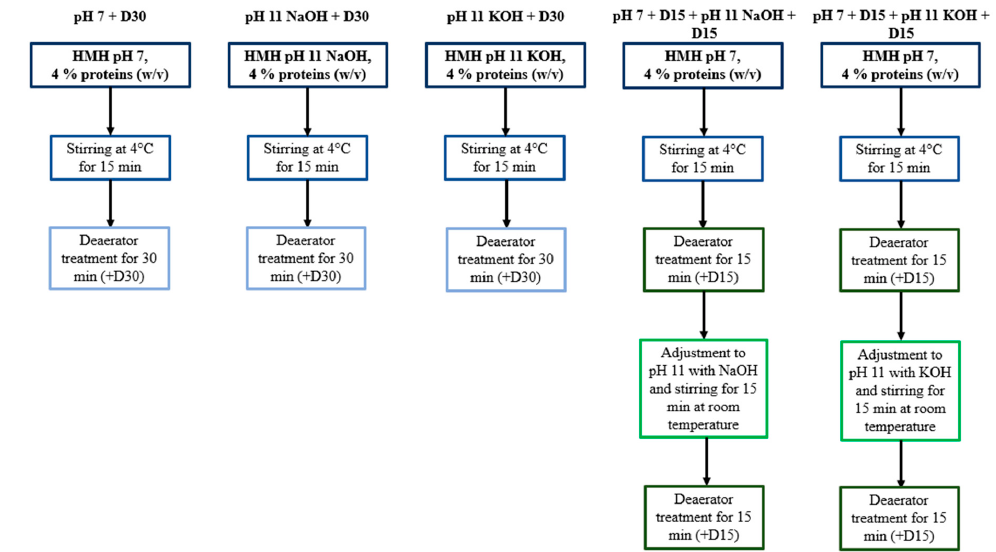
Figure 1. Summary of the experimental protocol.